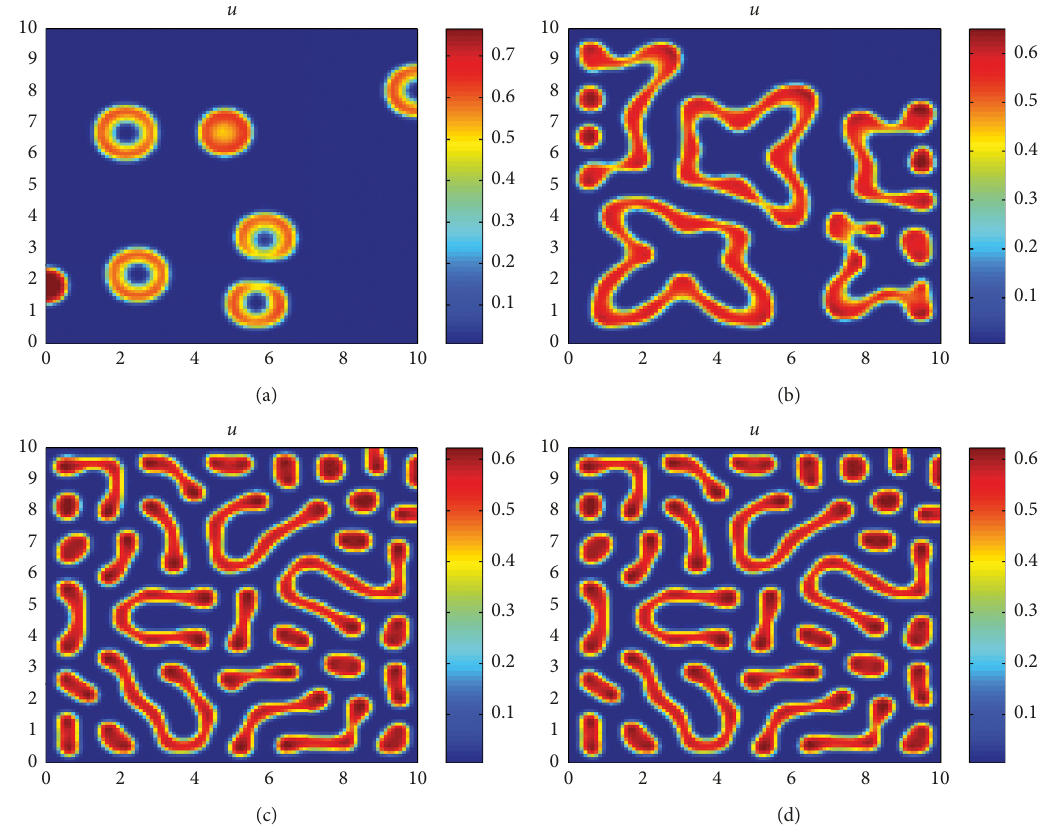
Figure 3: Mixture patterns obtained with model (1) for A � 0 . 1 and τ � 0. Time: (a) t � 100, (b) t � 500, (c) t � 2000, and (d) t �